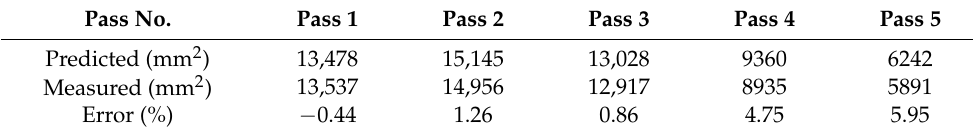
Table 1. Comparison of the predicted projected contact area and the measured values. Pass No.